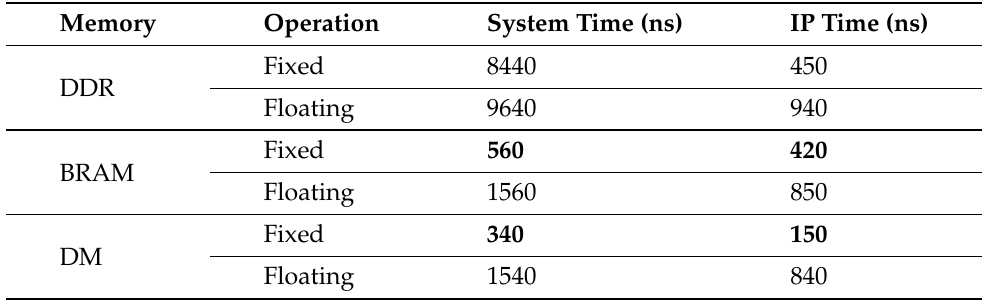
Table 2. Timing Analysis between the ONN models and system